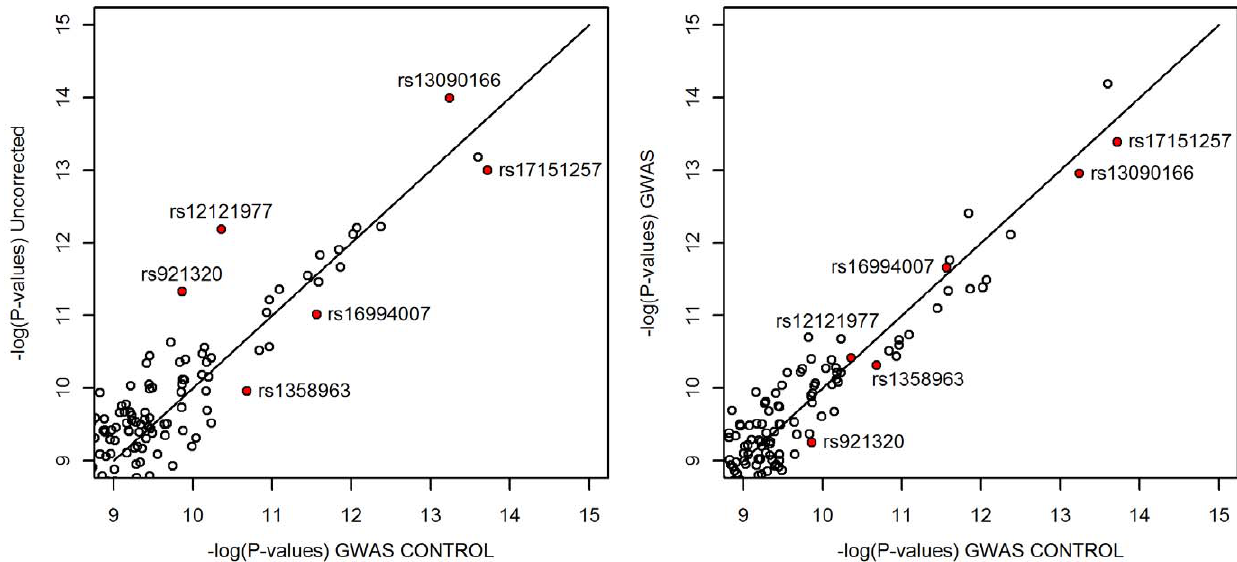
Figure 4. Top hits for ovarian cancer association. Negative log p-values of top hits for ovarian cancer association after controlling for ancestry using first 4 PCs of GWAS control PCA compared to not controlling for ancestry (left panel) and controlling for ancestry using first 4 PCs of GWAS PCA (right panel).